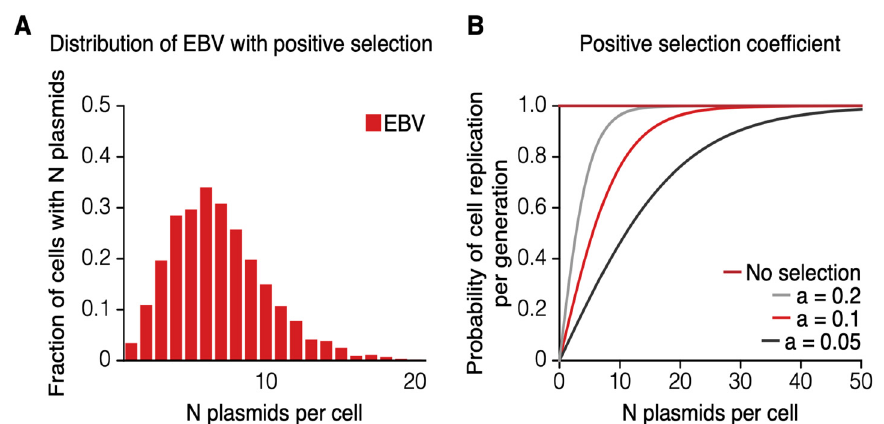
Figure 3. The distribution of the fraction of cells with given numbers of EBV plasmids per cell under positive selection is shown. ( A ) A distribution of the same form as in Figure 2 is depicted, but now calculated with a term for a positive selection. This positive selection is represented as an offset sigmoid function as follows: F ( x ) = 2 (cid:3276)(cid:3299) e ax + 1 (cid:4673) (cid:3398) 1 , where x equals the number of EBV plasmids per cell and “ a ” is the coefficient for positive selective as shown in Figure 3B. In the depicted distribution, “ a ” was set optimally to 0.1, so that the distribution mirrors that found in cells after 100 generations of growth in culture [16]. ( B ) The contribution to the number of plasmids per cell derived by altering computationally the coefficient of positive selection in the offset sigmoid function. The probability of a cell replicating each generation on the Y-axis is increased as a function of the number of plasmids per cell on the X-axis such that, as the coefficient decreases, the effect of positive selection more strongly selects for higher numbers of plasmids per cell.